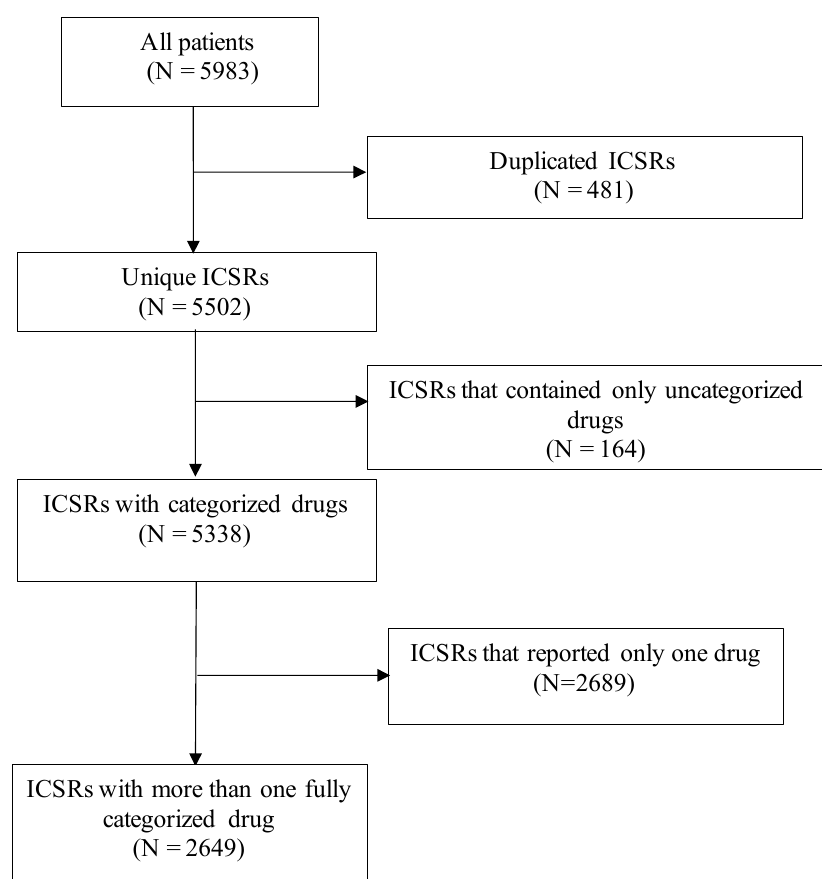
Figure 1. Flowchart of inclusion criteria. Acronyms: ICSR: individual case safety report. Table 1. Demographic characteristics of patients included in the network analysis, stratified by sex.